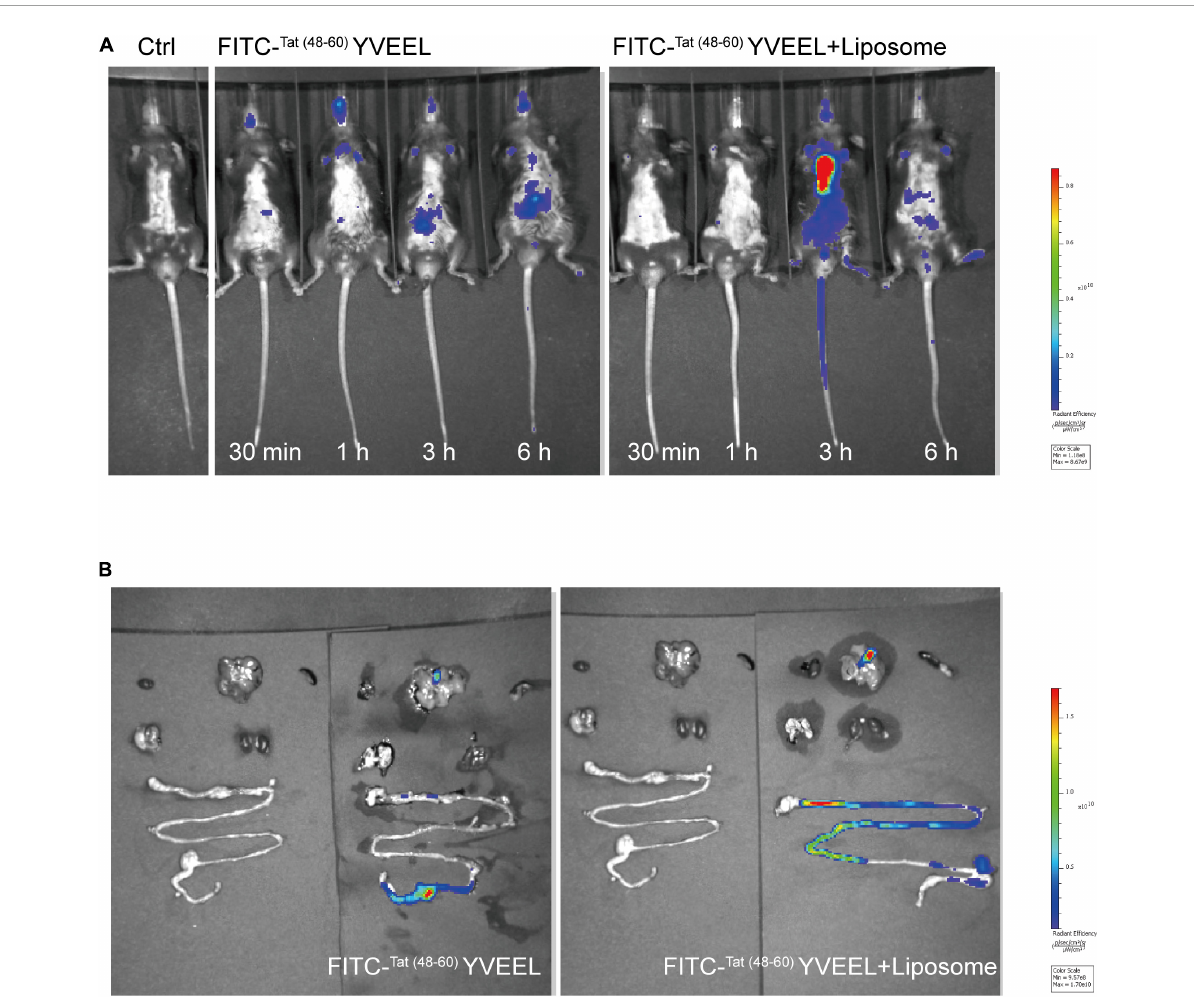
FIGURE6 Liposome encapsulation enhances dissolution and prolongs the intestinal residence time of Tat ( 48 - 60 ) YVEEL. (A) Distribution of FITC- Tat ( 48 - 60 ) YVEEL and FITC- Tat ( 48 - 60 ) YVEEL encapsulated into liposomes (FITC- Tat ( 48 - 60 ) YVEEL + liposomes) at indicated time after delivery of liposomes by oral gavage in C57BL6/J mice. (B) Fluorescence signal from FITC- Tat ( 48 - 60 ) YVEEL and FITC- Tat ( 48 - 60 ) YVEEL + liposomes, delivered through oral gavage in C57BL6/J mice 3 h after